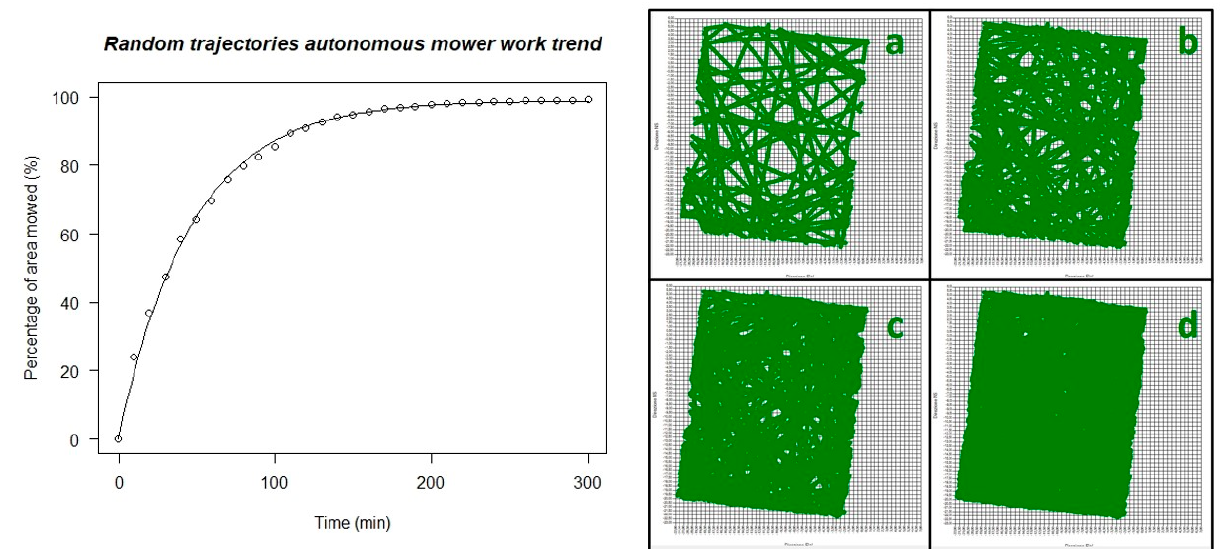
Figure 4. ( Left ) Data trend of mowed area percentage as a function of time (min) for the autonomous mower with random trajectories working on 500 m 2 : observed values averaged across 4 replications (dots) and regression curve (solid line). ( Right ) Custom-built software showing the mowed area on 2 November 2020 at different time intervals: ( a ) 60 min; ( b ) 120 min; ( c ) 180 min; ( d ) 300 min.